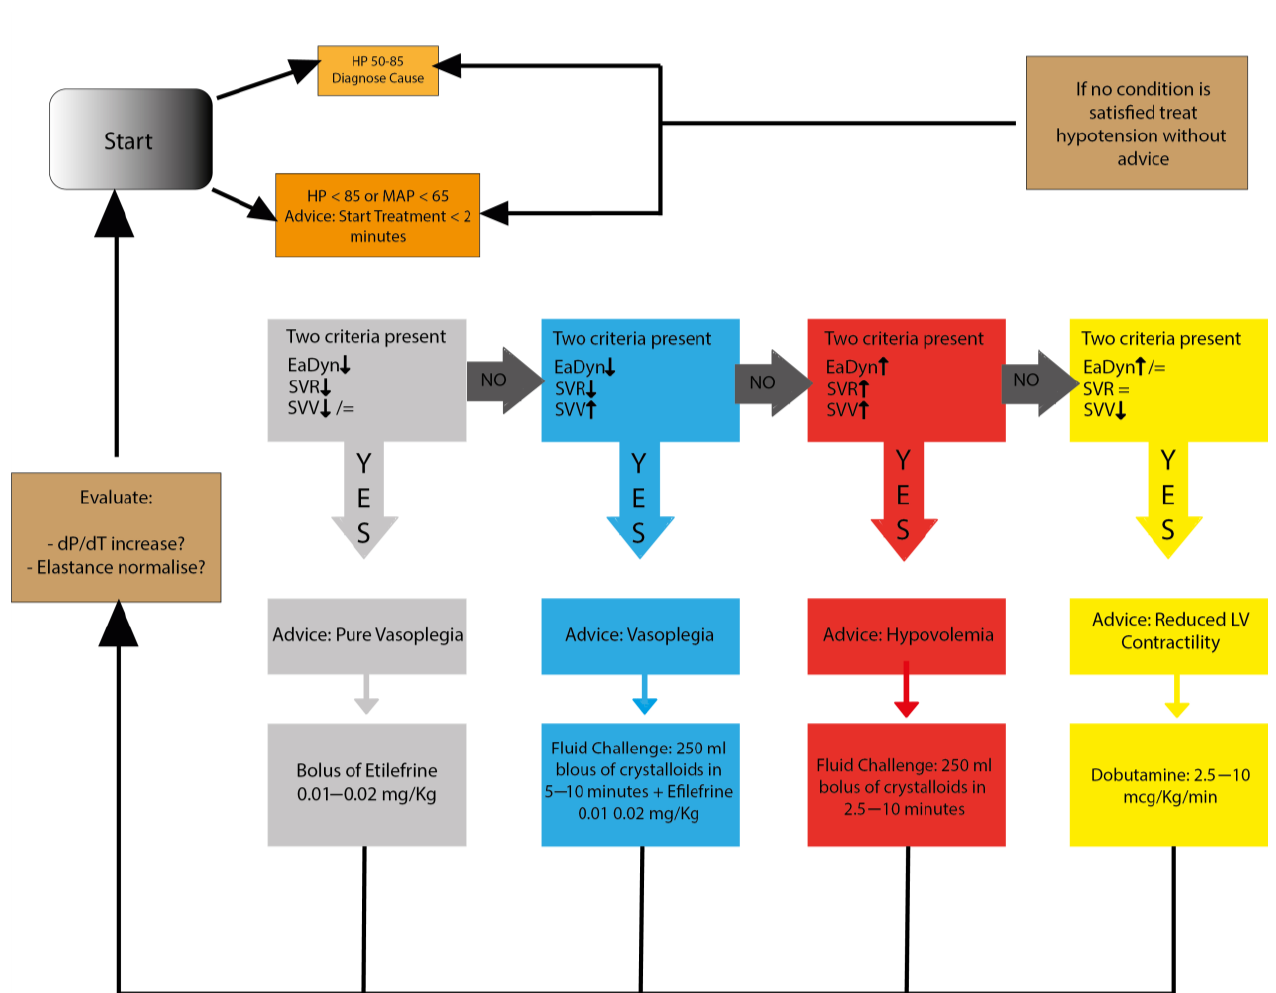
Figure 2. Algorithm for hemodynamic management used in the intervention group and coupled with the hypotension prediction index. Arrows indicate the clinical decision to be followed according to patient parameters.